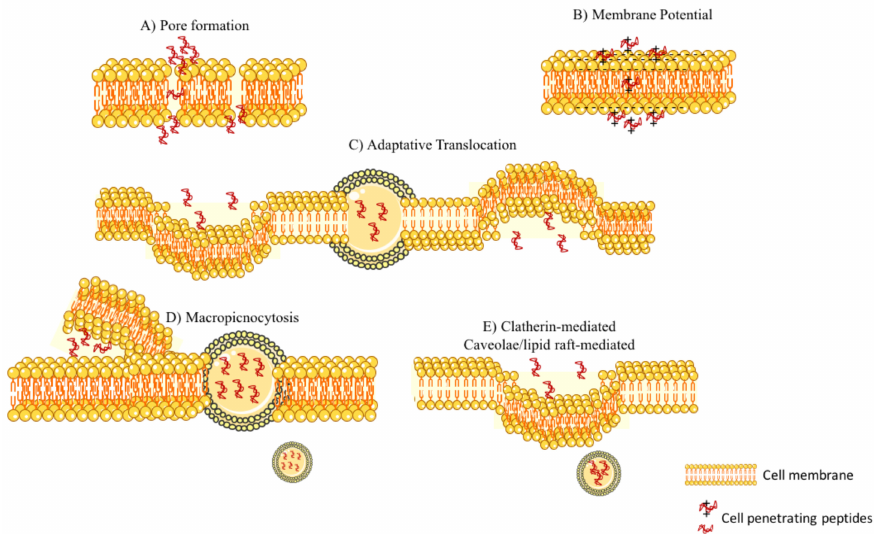
Figure 2. Intracellular pathways of cell entry for charged-cell penetrating peptides (CPPs): ( A ) Transient toroid pore formation; ( B ) membrane potential; ( C ) adaptative translocation; ( D ) micropinocytosis; and ( E ) clathrin-mediated endocytosis and caveolae/lipid raft-mediated